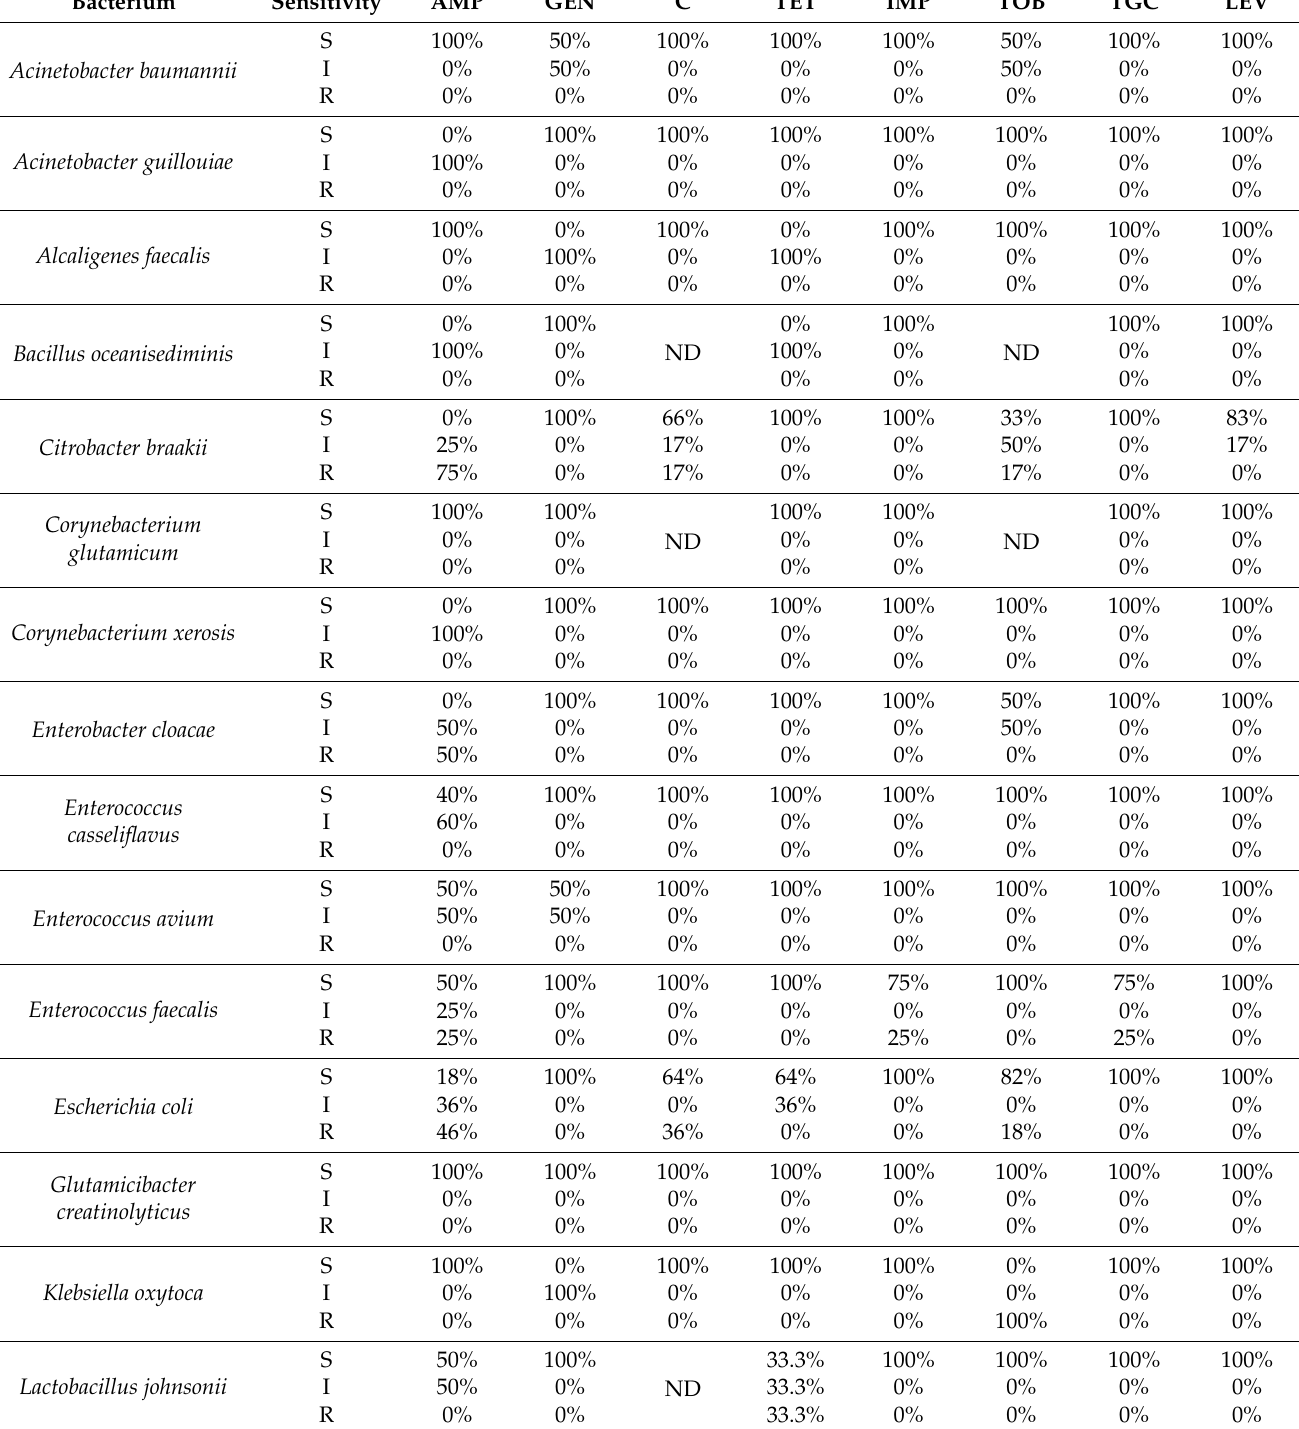
Table 3. Resistance profiles of bacteria recovered from Lohmann Brown (LB) and ROSS 308 (R 308) rooster